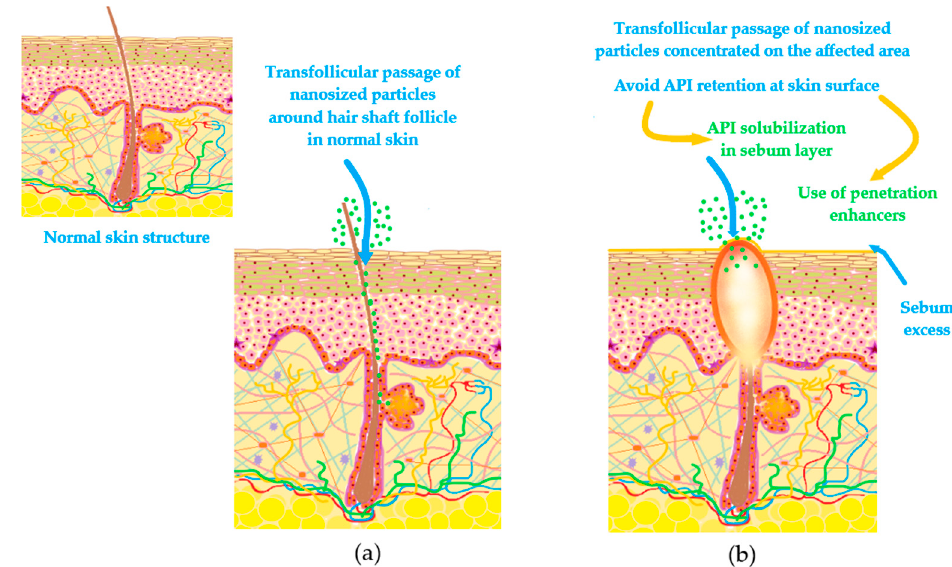
Figure 4. Transfollicular passage of nanosized particles in skin structure: ( a ) transfollicular passage around hair shaft follicle in normal skin; ( b ) modified passage accessing hair shaft follicle in acne affected skin with comedonal development and inflammation flare.